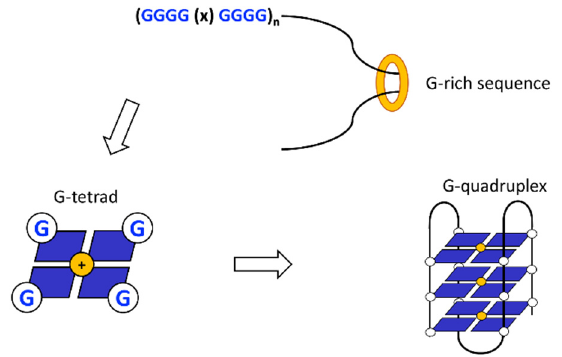
Figure 3. G-quadruplex DNA is formed by G-rich sequences. Guanines at G-rich sequences can interact to form higher order structures. If stabilised by the presence of monovalent cations, guanines can form a planar structure called G-tetrad or G-quartet by Hoogsteen hydrogen bonds. Multiple planar structures can stack onto each other to form bi-, tri-, tetramolecular G-quadruplexes.